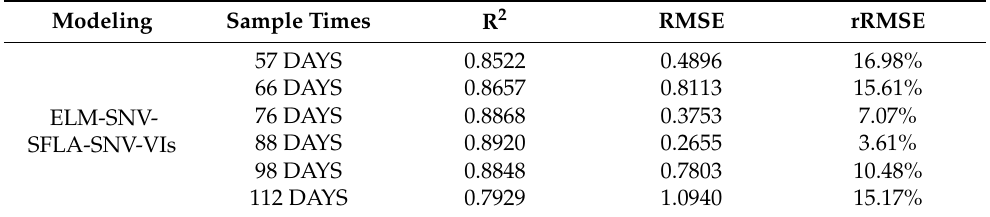
Figure 13. Model testing result. ( a ) Test accuracy of ELM-SNV-SFLA-SNV-VIs model under differ- ent sample times. ( b ) Test accuracy of ELM-SNV-SFLA-SNV-VIs model under different nitrogen application levels. ( c ) Optimal model external test results. Table 9. Cotton LAI monitoring verification results of different sample times in the optimal